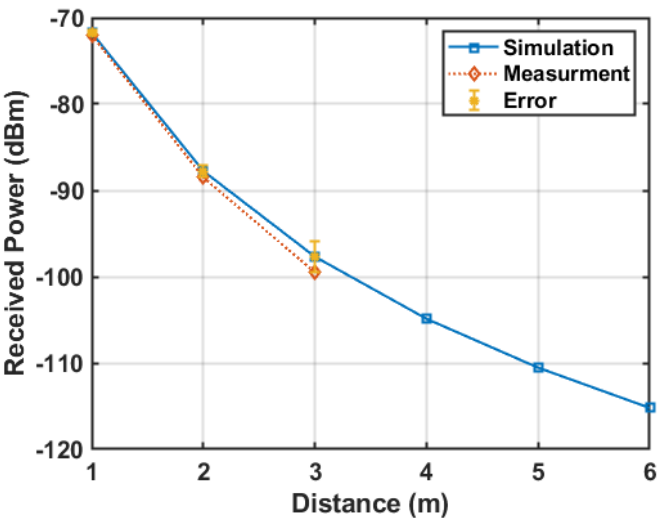
Figure 12. Simulated and measured